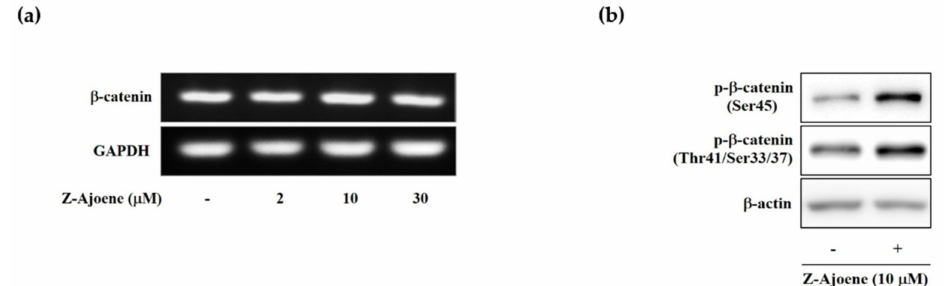
Figure 3. E ff ects of Z-ajoene on phosphorylation at Ser45 of β -catenin in SW480 colon cancer cells. ( a ) the mRNA levels of β -catenin were measured by RT-PCR in SW480 colon cancer cells with Z-ajoene for 15 h; ( b ) SW480 cells were treated with / without Z-ajoene in the presence of MG132 (proteasome inhibitor, 10 µ M) for 15 h and then levels of phosphorylated β -catenin (p- β -catenin) were measured by Western blotting. The images are representative of three independent experiments with similar